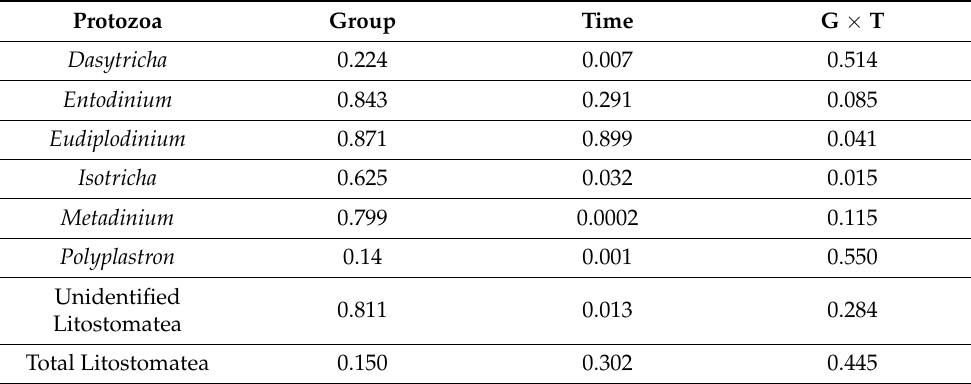
Figure 6. Relative abundance (% eukaryotic population) of protozoa in the ruminal samples from the control and SC groups ( n = 6 per group) at BS, Pa and PP. Table 7. p -values associated with the statistical analysis of the relative abundances of eukaryote phyla in the ruminal samples with a linear mixed model. Only genera with relative abundance >2.3% were kept for statistical analysis, except Eudiplodinium whose abundance was <2.3% but which is a functionally important ciliate genus in the